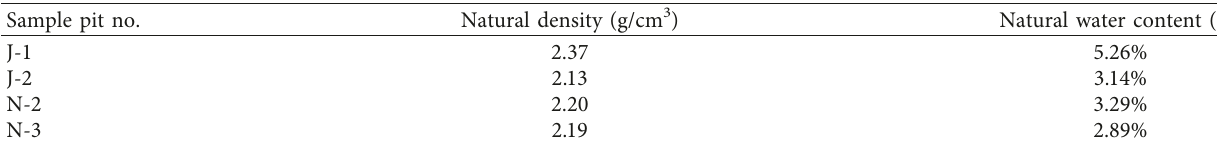
Table 3: Bulk density and water content of waste rocks.